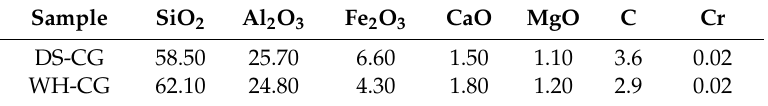
Table 3. Chemical components of CG (wt %).